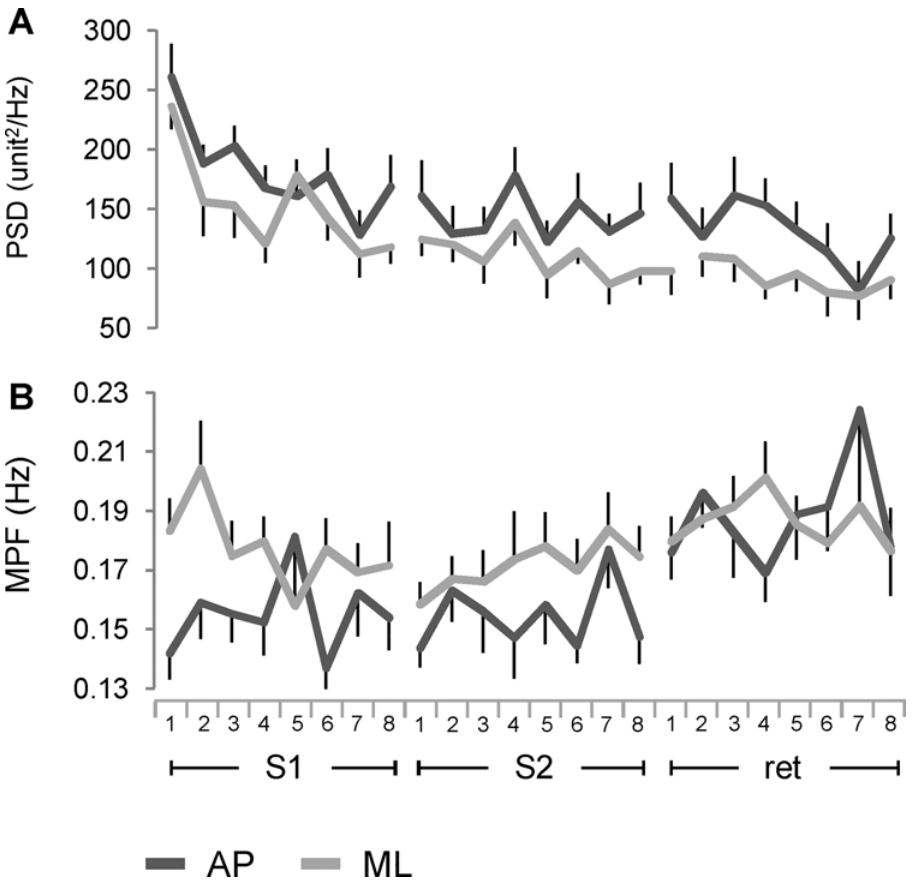
Fig 6. Changes in frequency domain across the time course of learning. Power Density Spectrum (A) and Mean Power frequency (B) computed from the time series of the unit normal vector along AP and ML directions. Symbols unit in A and abbreviations as in Figs 2 and